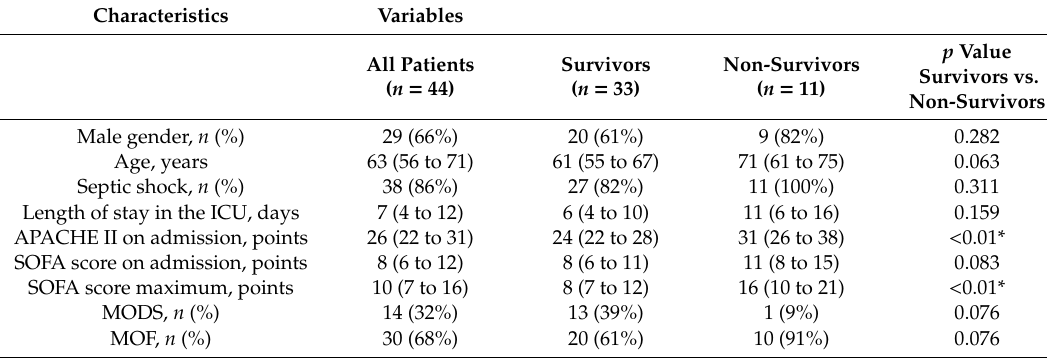
Table 1. Patient demographics. All patients, sepsis 30-day survivors and non-survivors are listed. Data are expressed as medians and 25th to 75th percentiles or with frequencies and percentages. p value is statistically significant when < 0.05 and those values are marked with an *. ICU = intensive care unit; APACHE II = acute physiology and chronic health evaluation II; SOFA = sequential organ failure assessment; MODS = multiple organ dysfunction syndrome; MOF = multiple organ